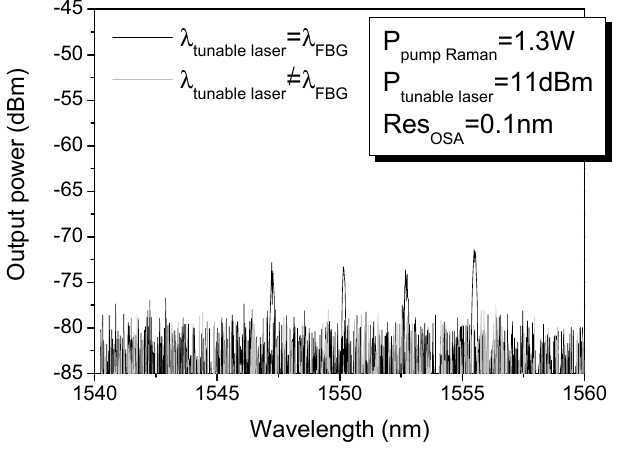
Figure 7. Spectrum of the reflected signal from the remotely multiplexed four FBG.